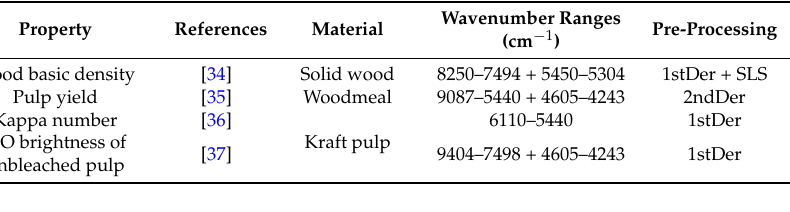
Table 3. Wavenumber ranges and pre-processing used in the NIR-PLS-R (infrared ( NIR ) partial least squares regression ( PLSR ) models published in bibliography for different properties of Acacia melanoxylon .